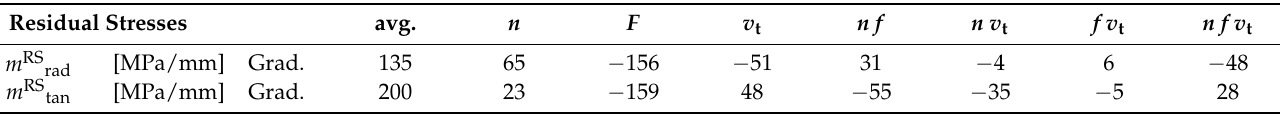
Table 4. Effects and interactions (DoE) of the parameters (1.0308) on the gradients of the residual stress depth distribution m RS in the tangential and radial